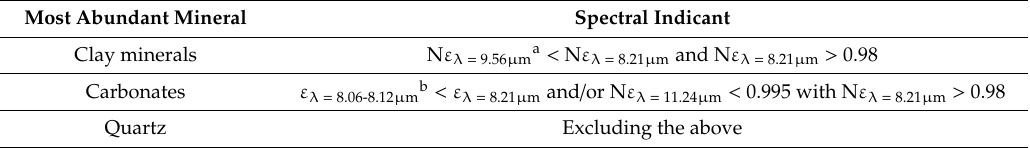
Table 2. Spectral indicants of minerals.